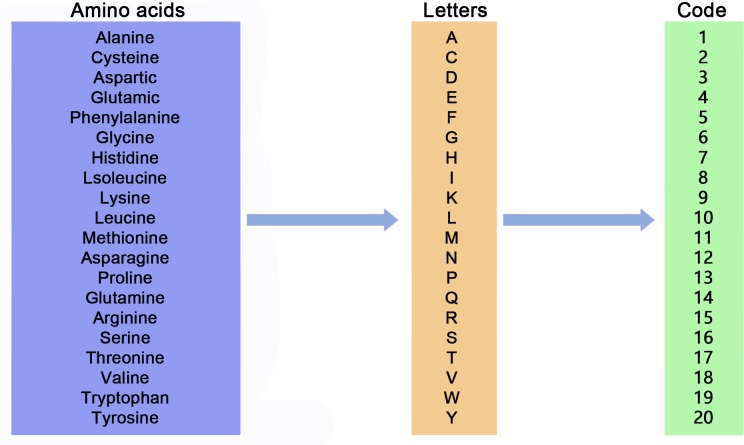
Amino acid encoder.